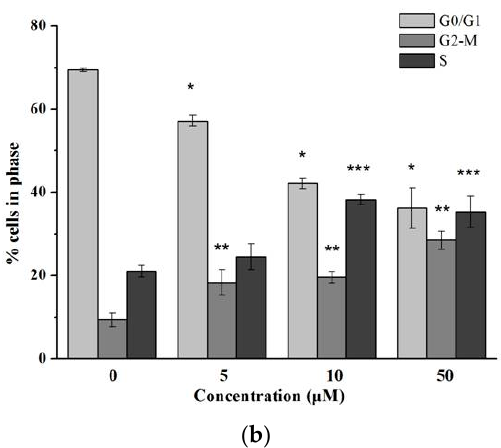
Figure 3. The cycle analysis of MCF-7 cell treated with V 18 for 24 h. Data are presented as the mean ± SD ( n = 3). ( a ) The cycle analysis of MCF-7 cells treated with 0, 5, 10, 50 µ M V 18 ; ( b ) The cell rate of G 0 /G 1 , S, and G 2 -M phase cells treated with 0, 5, 10, 50 µ M V 18 . * p < 0.05 for G 0 /G 1 phase compared to control group. ** p < 0.05 for G 2 -M phase compared to control group. *** p < 0.05 for S phase compared to control group.